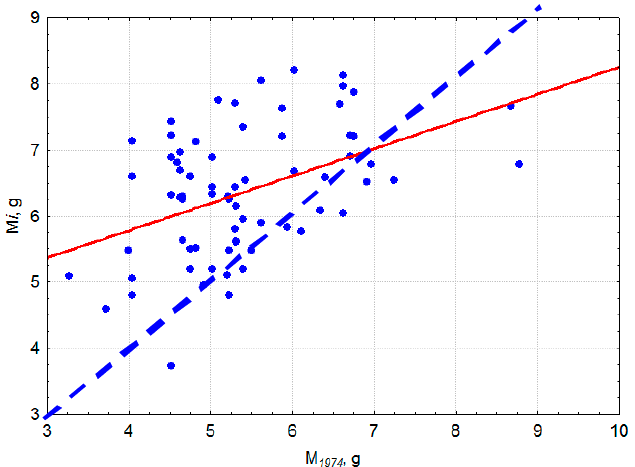
Figure 5. The relationship between provenance seed mass (M i ) for 1999-2003 and 2010 in the Boguchany common garden trial and provenance seed mass in 1974.